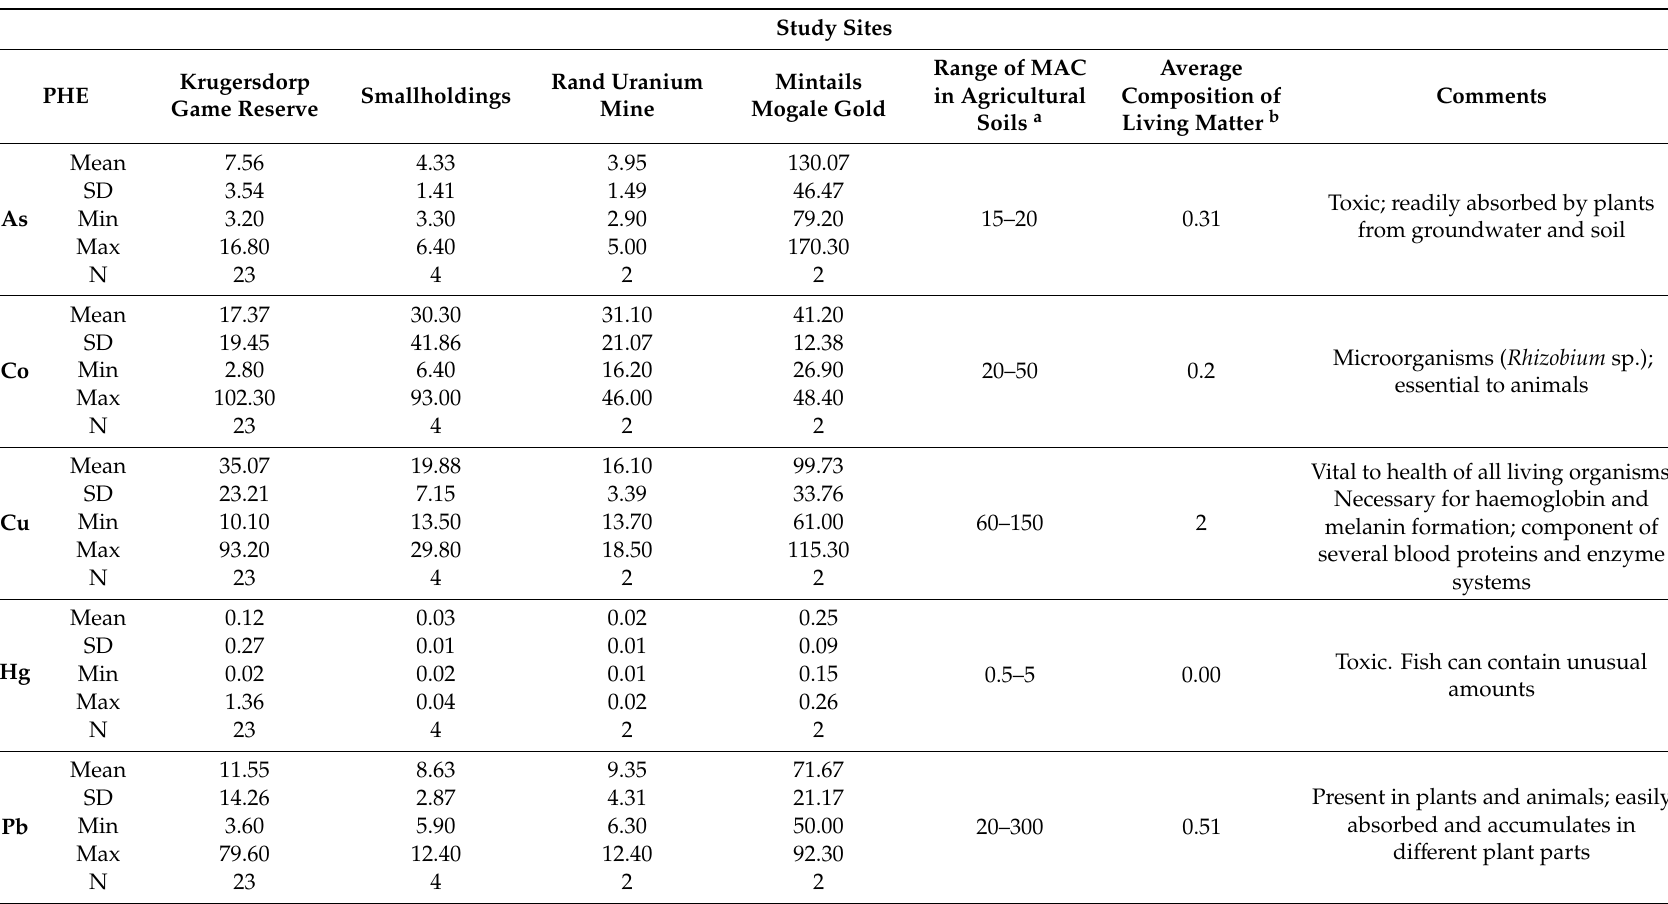
Table 4. As, Co, Cu, Hg and Pb (ppm) in agricultural soils and in living matter, compared with mean values in soils of the study localities. a [29] ; b [30] .